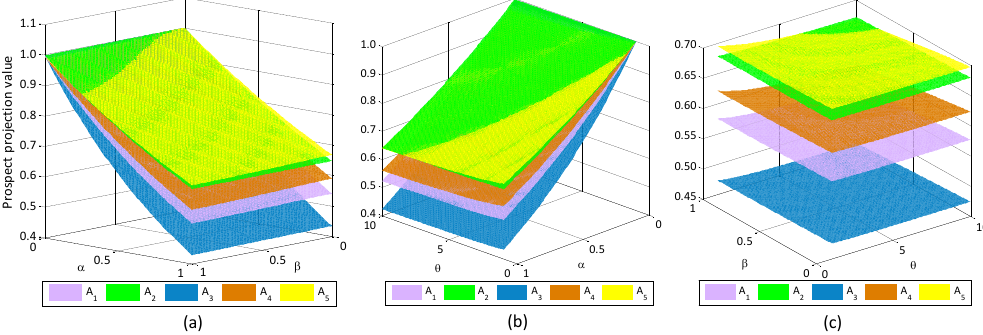
Figure 5. Sensitivity analysis of the optimal alternatives with respect to two parameters: ( a ) α and β ; ( b ) α and θ ; ( c ) β and θ .